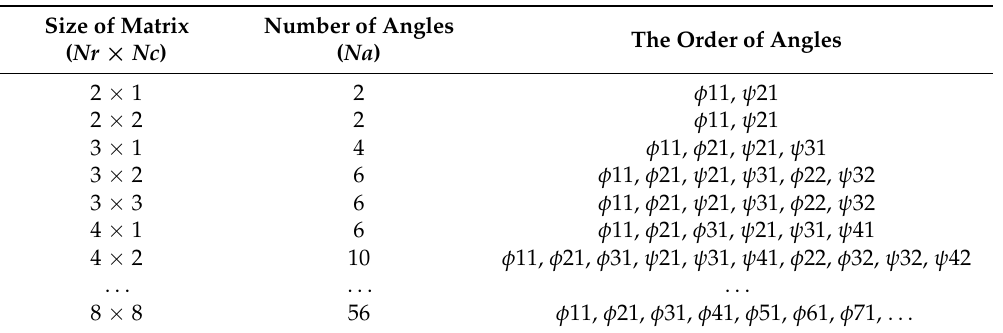
Table 2. List of φ and ψ